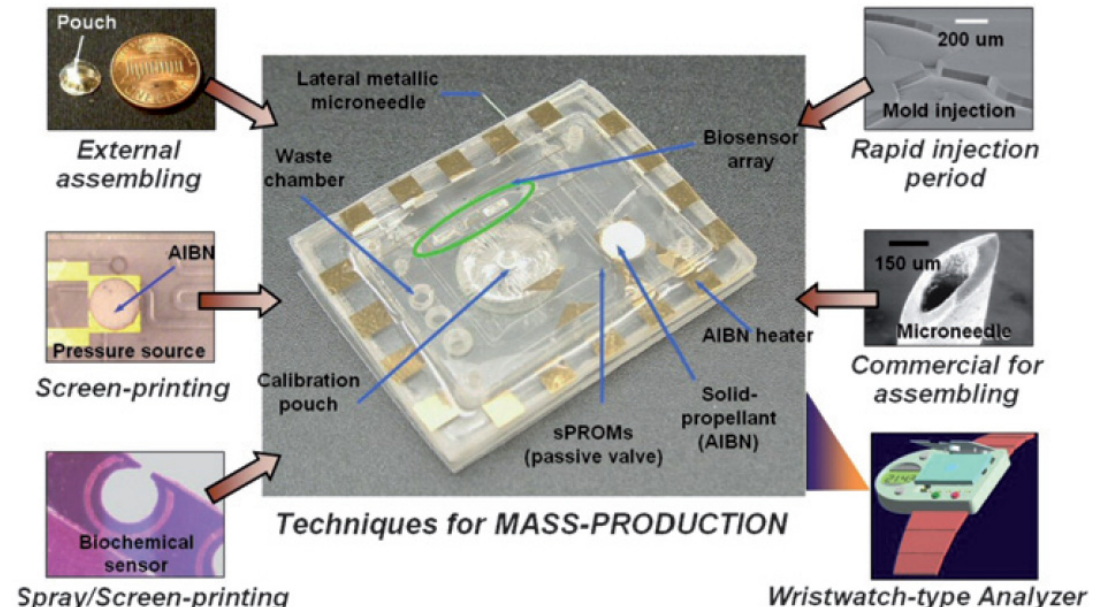
Figure 5. Disposable multifunctional biochip with wristwatch-type analyzer for POC clinical diagnostics (Reprinted with permission from